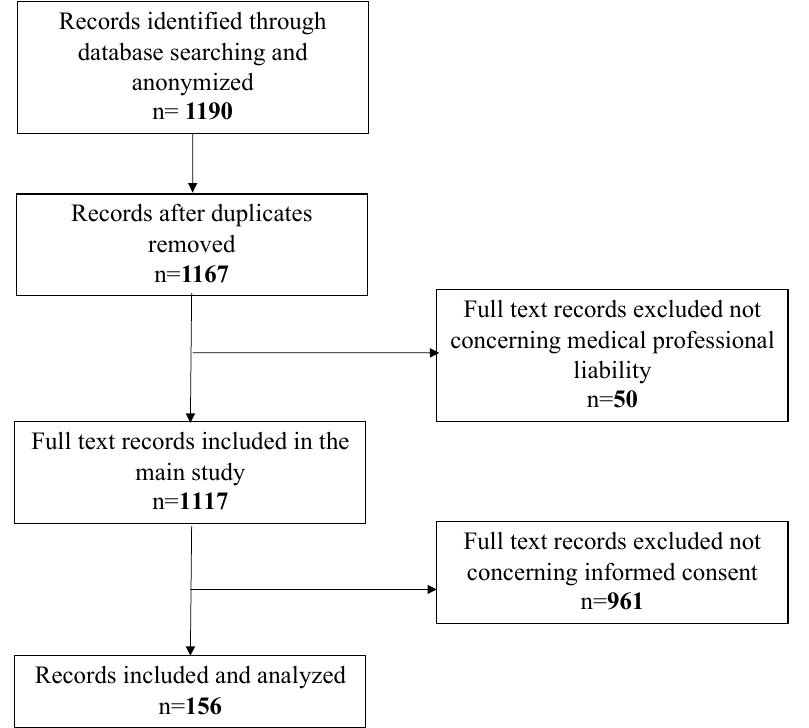
Figure 1. Flowchart reassuming the process of document selection.